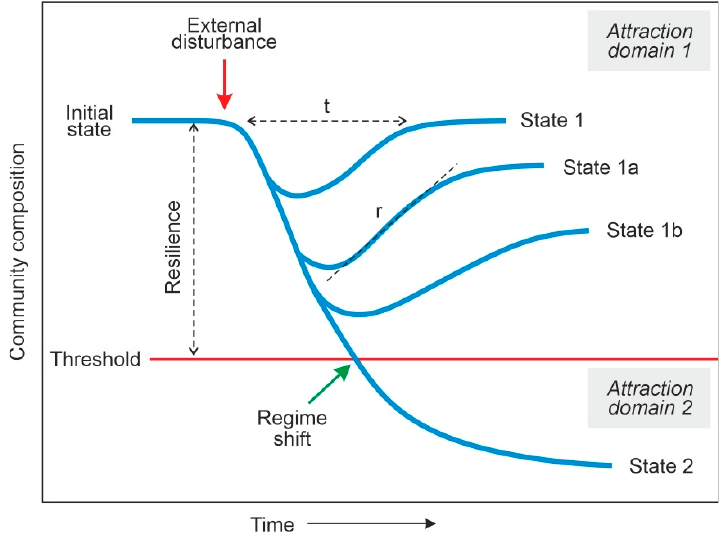
Figure 1. Changes in the composition of a hypothetical community after a temporal external disturbance. t, return time; r, recovery rate. Redrawn and modified from Ref. [6]. In the case of forests, resilience has been divided into three different components, namely, persistence, recovery and reorganization [7]. Persistence (no apparent change) and recovery (return to the initial state) occur within the same attraction domain, whereas reorganization implies deeper compositional variations that may be transient (i.e., occurring within the same attraction domain) or persistent if the threshold between two attraction domains is crossed (regime shifts). Changes in composition within the same attraction domain imply variations in the relative abundances of the already existing species or individual species replacements. A regime shift involves complete species turnover, which means replacement by a different forest or by a nonforested community (deforestation), and has been called community replacement [8,9] or vegetation type conversion [7].